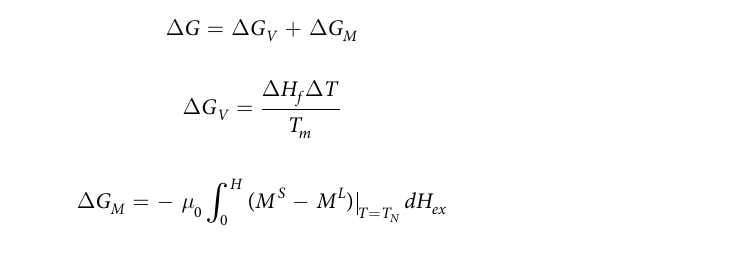
4 Scientific RepoRts | 7: 4958 | DOI:10.1038/s41598-017-05385-y